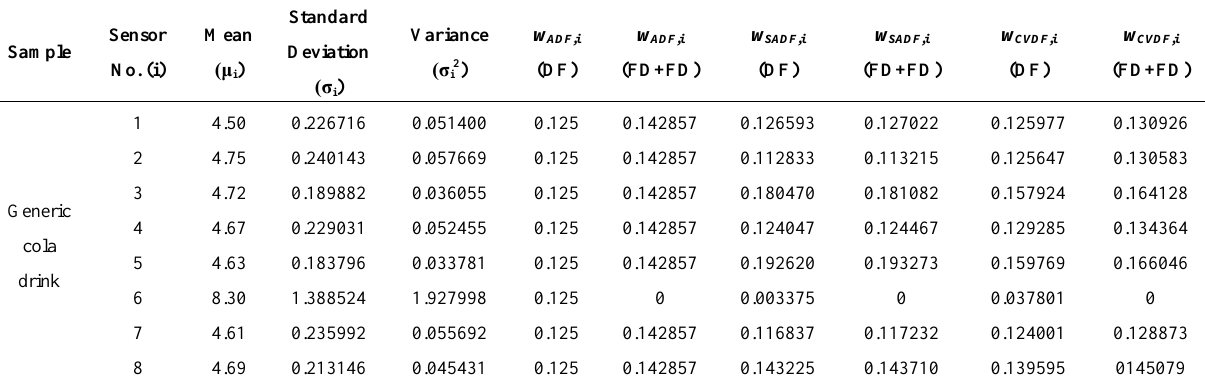
Table 2. Comparison of weighted coefficients of ADF, SADF and CVDF with fault diagnosis and obtained from the mean, standard deviation and variance of sensor measured data (sample: generic cola